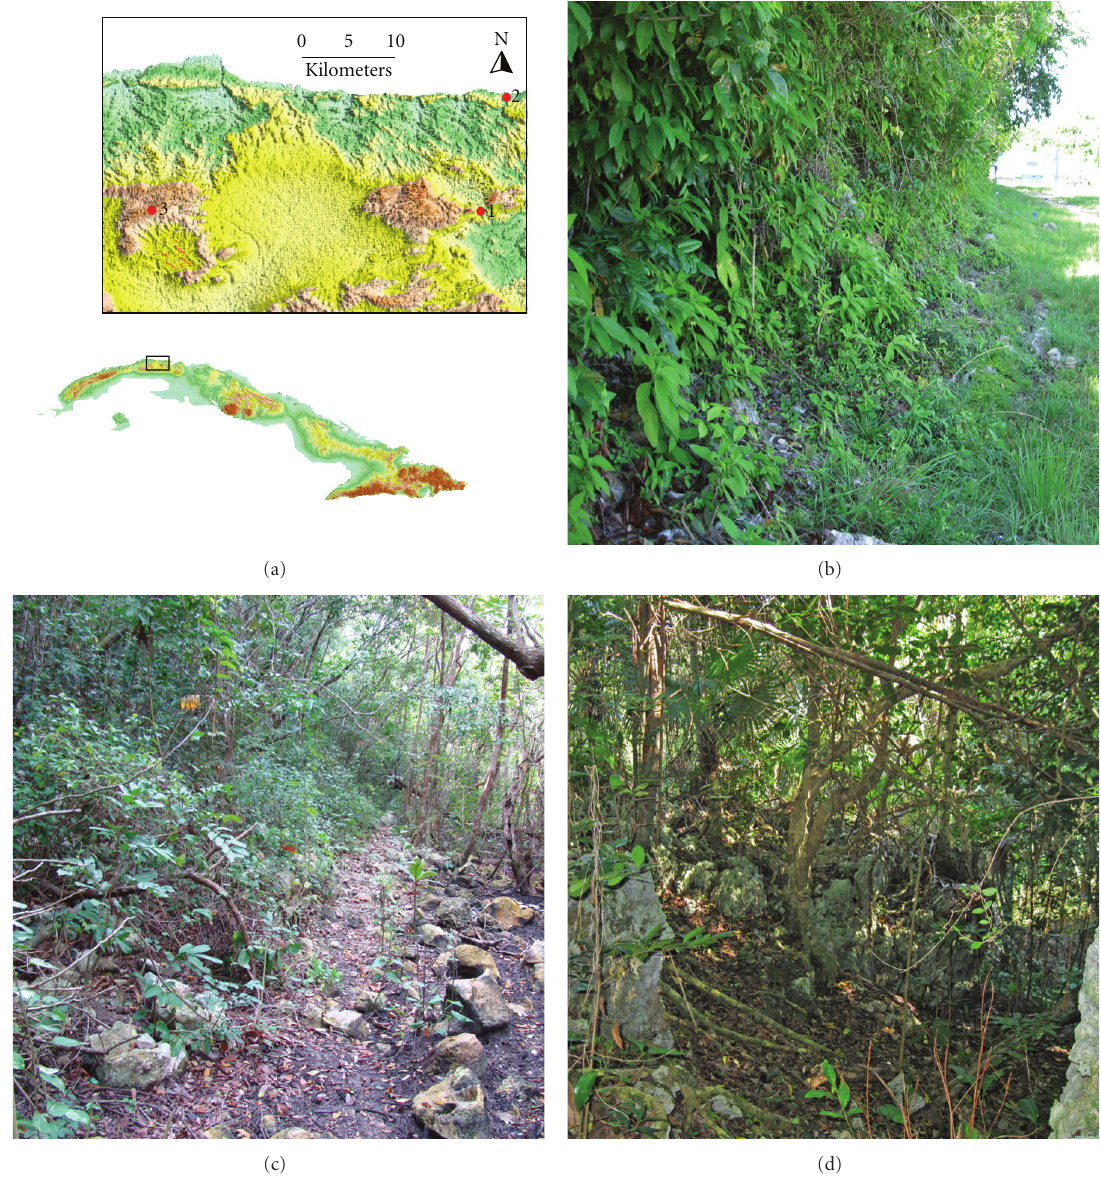
Figure 1: (a): Collection localities of Alecton discoidalis larvae in western Cuba: 1- Pan de Matanzas, 2- Bacunayagua, 3- Escaleras de Jaruco, La Jaula. (b): Habitat at Pan de Matanzas, Matanzas. (c): Habitat at Bacunayagua, Matanzas. (d): Habitat at Escaleras de Jaruco, La